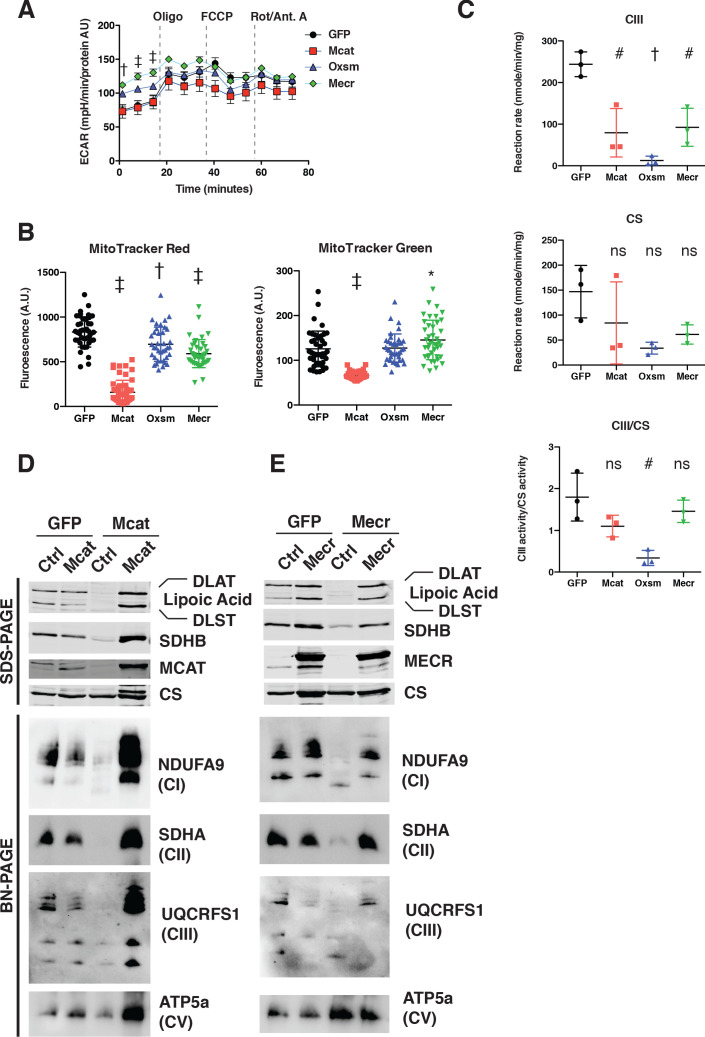
ETC complex assembly and activity is regulated by interaction of LYRM proteins with ACP.(A) Cells from three clones of each of the indicated genotypes were seeded in eight wells of a 96-well seahorse plate and allowed to adhere overnight, then equilibrated and treated with the indicated drugs following standard mitochondrial stress test protocols from the manufacturer to determine ExtraCellular Acidification Rate (ECAR). (B) Cells of the indicated genotype were seeded in chambered coverglass slides, stained with Mitotracker Red and Mitotracker Green, and imaged. Fluorescence of cells from 30 fields of view was quantified using Fiji ImageJ. *=p < 0.05, †=p < 0.001, ‡=p < 0.0001 all comparisons are to GFP control, error bars are SD. (C) Crude mitochondrial fractions were isolated from triplicate biological samples of mtFAS mutant and control cells using differential centrifugation. Isolated mitochondria were normalized for protein content via BCA assay and analyzed for Bc1-complex activity and citrate synthase activity (CS). ns = non significant, #=p < 0.01, †=p < 0.001, error bars are SD.